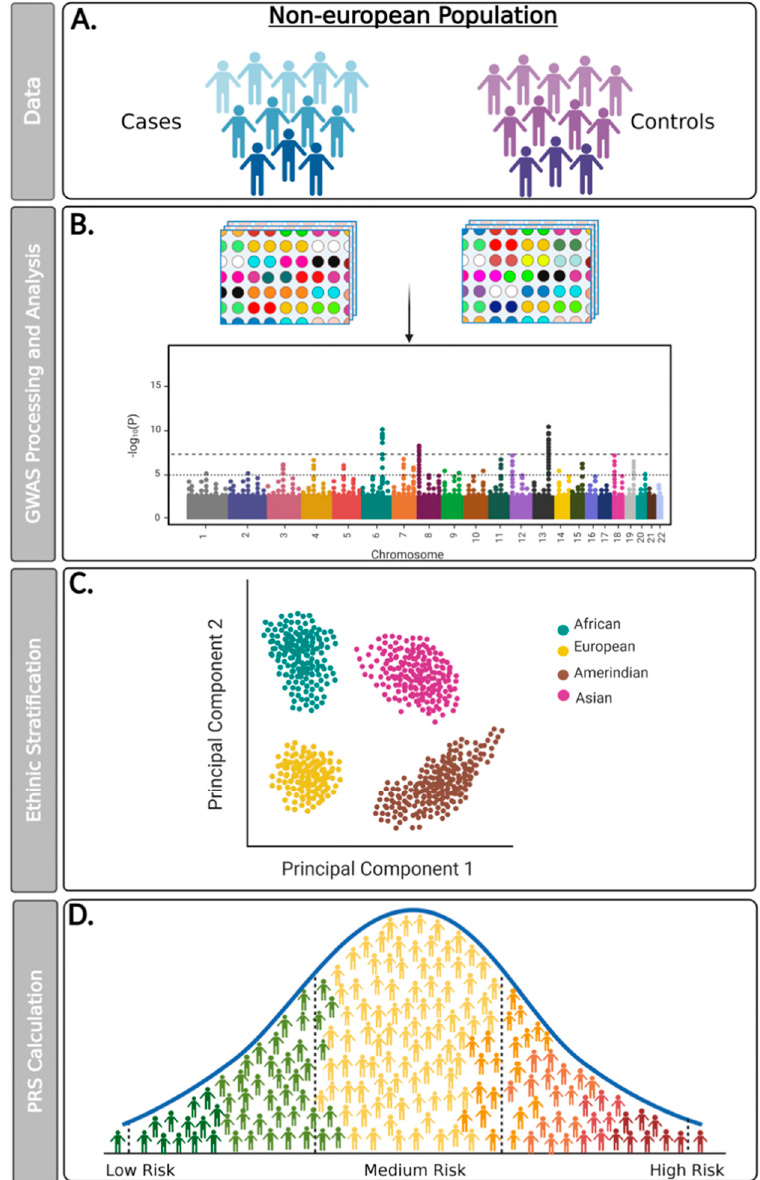
Figure 1. Flowchart detailing proposed steps for conducting GWAS data analysis and PRS calculation for non-European populations. ( A ) Genomic data can be collected from a new study of cohorts developed in multiethnic populations or from genetic information from biobanks or public repositories; ( B ) Genotyping assays must be performed from large-scale microarray platforms and analyzed with reliable bioinformatic tools that use safe quality controls and seek to minimize sampling bias. It is recommended that genotypic data obtained from the GWAS study be paired with information from matched reference populations from repositories such as the 1000 Genomes Project; ( C ) The microarray platform used must encompass genetic variants that allow for the ethnic stratification of the evaluated population (e.g., African, American, Asian, and European); ( D ) The PRS calculation must be performed from an individual’s genetic risk estimate to a trait or disease. The polygenic risk score (PRS) consists of an individual’s genetic risk estimate for a trait or disease, calculated through a weighted sum of allele counts, according to their genotype profile and relevant GWAS data, combined or not with non-genetic variables.